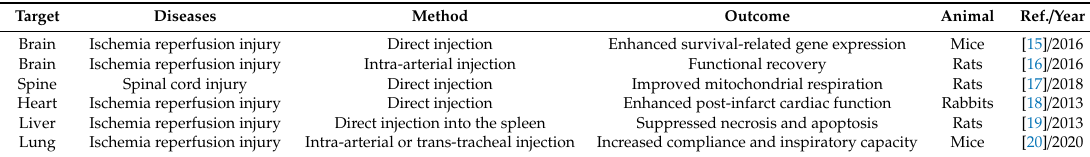
Table 1. Exogenous mitochondrial transplantation in animal